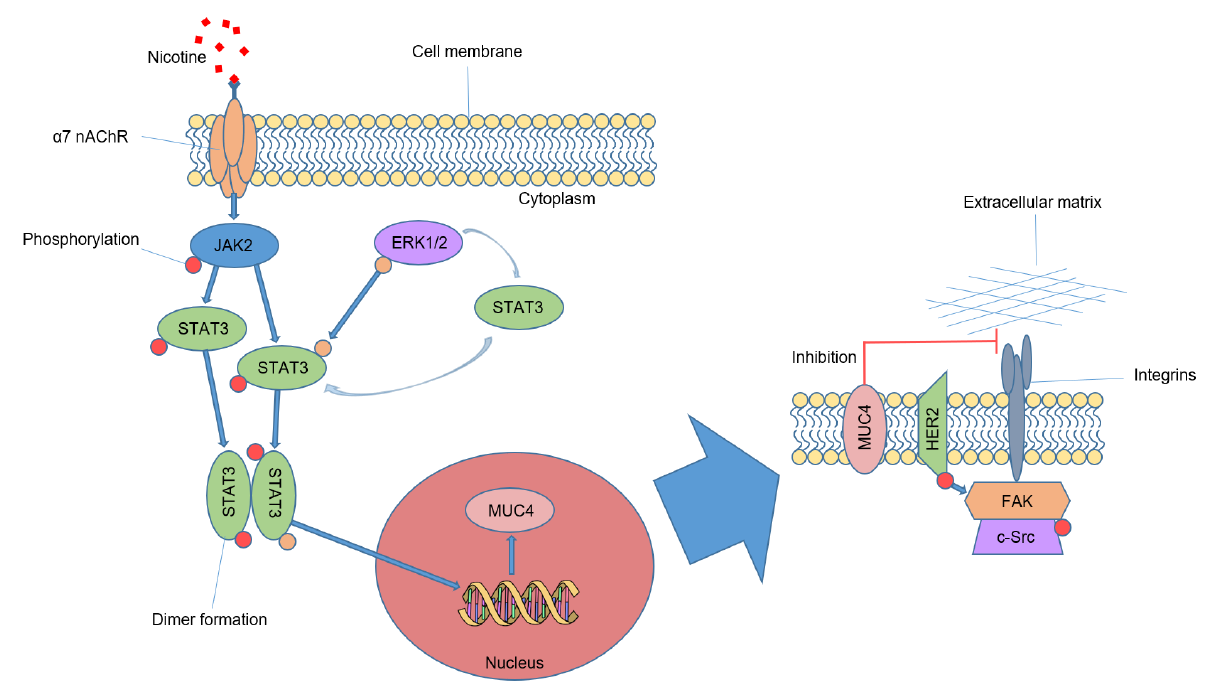
Figure 2. Nicotine induced stimulation of pancreatic cancer cell metastasis in vitro . Nicotine interacts with the α 7 nAChR on the cell surface, activating JAK2 and leading to the phosphorylation of STAT3. ERK1/2 mediated STAT3 phosphorylation is known to enhance DNA binding and to stabilize STAT3 in the cytoplasm. The phosphorylated forms of STAT3 join to form dimers and translocate into the nucleus where they interact with the DNA causing upregulation of MUC4. MUC4 is then expressed on the cell membrane and either directly inhibits the integration of integrins with extracellular matrix, or indirectly through HER2 activation. These pathways lead to a decrease in cell-to-cell adhesion and increase the migratory potential of pancreatic cancer cells. This figure has been reproduced with permission from Momi et al.,